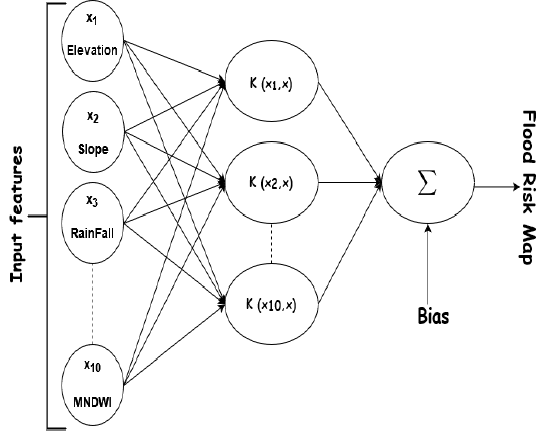
Figure 5 . The general structure of the SVM model (Adapted from Xu et al.,